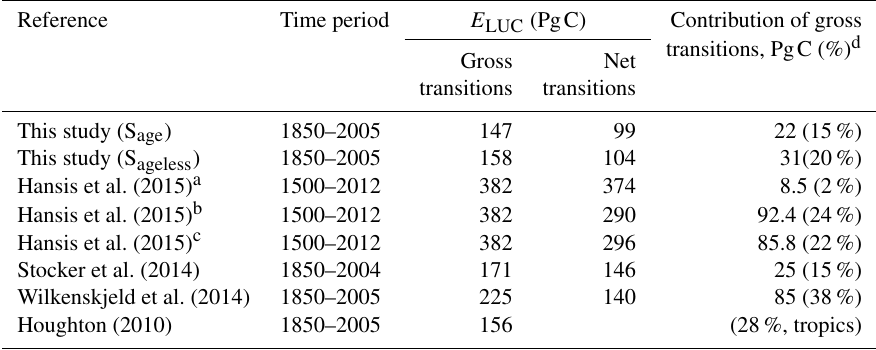
Table 4. Carbon emissions from gross and net land use transitions and contributions of gross transitions to the total emissions from different studies, adapted from Hansis et al.